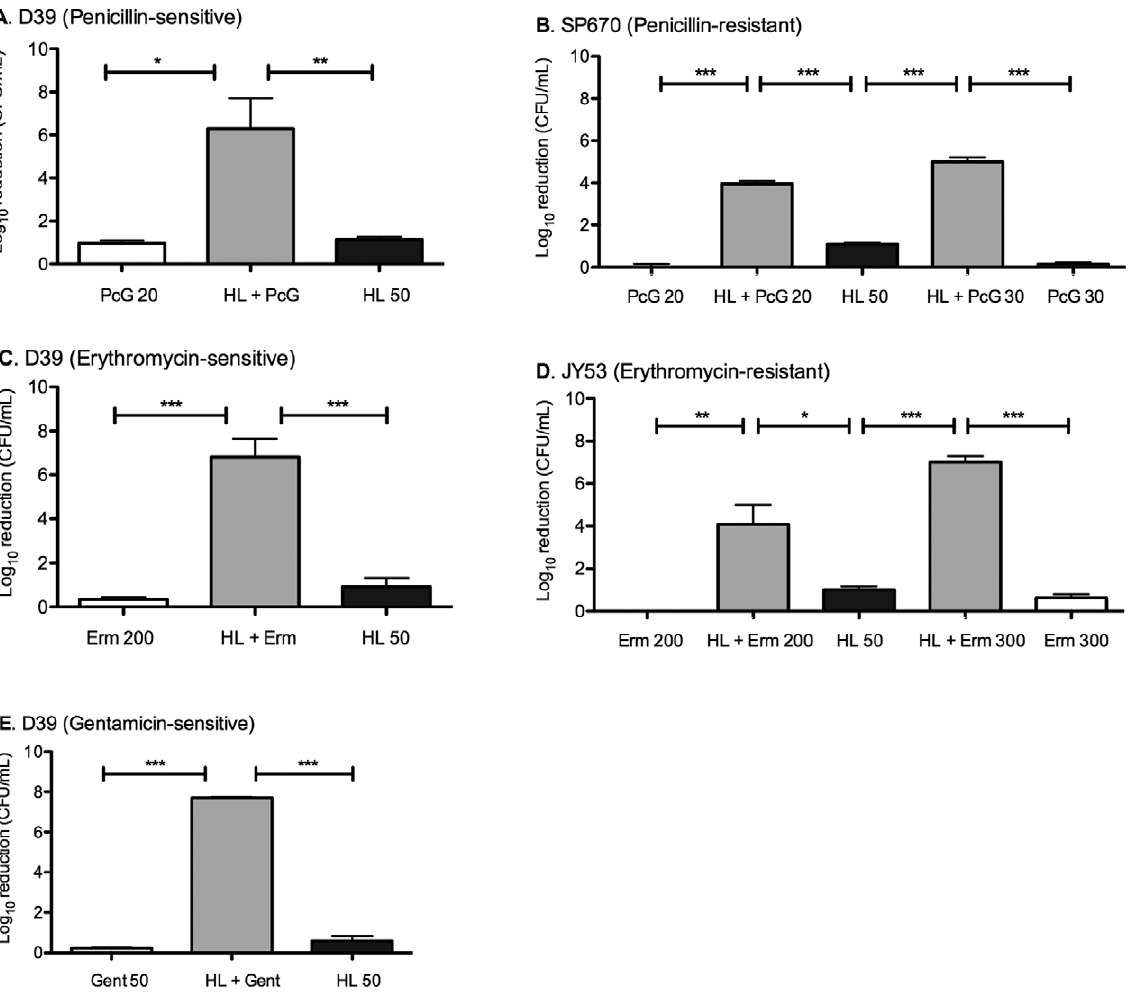
Figure 2. Potentiation of short-time pneumococcal killing by gentamicin, penicillin and erythromycin in the presence of HAMLET. Short-time killing of the penicillin-sensitive strain D39 (A) by penicillin G (20 m g/mL), HAMLET (50 m g/mL) and penicillin combined with HAMLET over 4 hours. (B) Killing of the penicillin-resistant strain SP670 by penicillin G (20 or 30 m g/mL), HAMLET (50 m g/mL), or penicillin G combined with HAMLET over 4 hours. (C) Killing of the erythromycin-sensitive strain D39 by erythromycin (200 m g/mL), HAMLET (50 m g/mL), or erythromycin combined with HAMLET over 4 hours. (D) Killing of the erythromycin-resistant D39-derivative JY53 by erythromycin (200 m g/mL), HAMLET (50 m g/mL), or erythromycin combined with HAMLET over 4 hours. (E) Killing of D39 by gentamicin (50 m g/mL), HAMLET (50 m g/mL), or gentamicin combined with HAMLET over 1 hour. The results are based on three individual experiments with duplicate samples and are expressed as means 6 S.D. Statistics was performed using the unpaired Student t-test. Significance was indicated as follows: *= P , 0.05, **= P , 0.01, ***= P , 0.001, ns = not